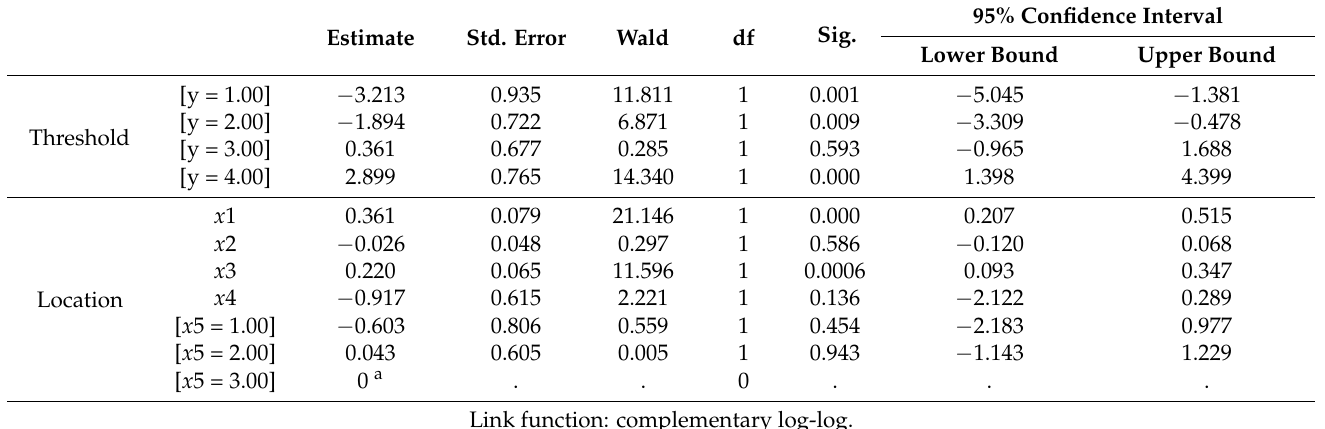
Table 2. Parameter estimates for the ordinal regression model.